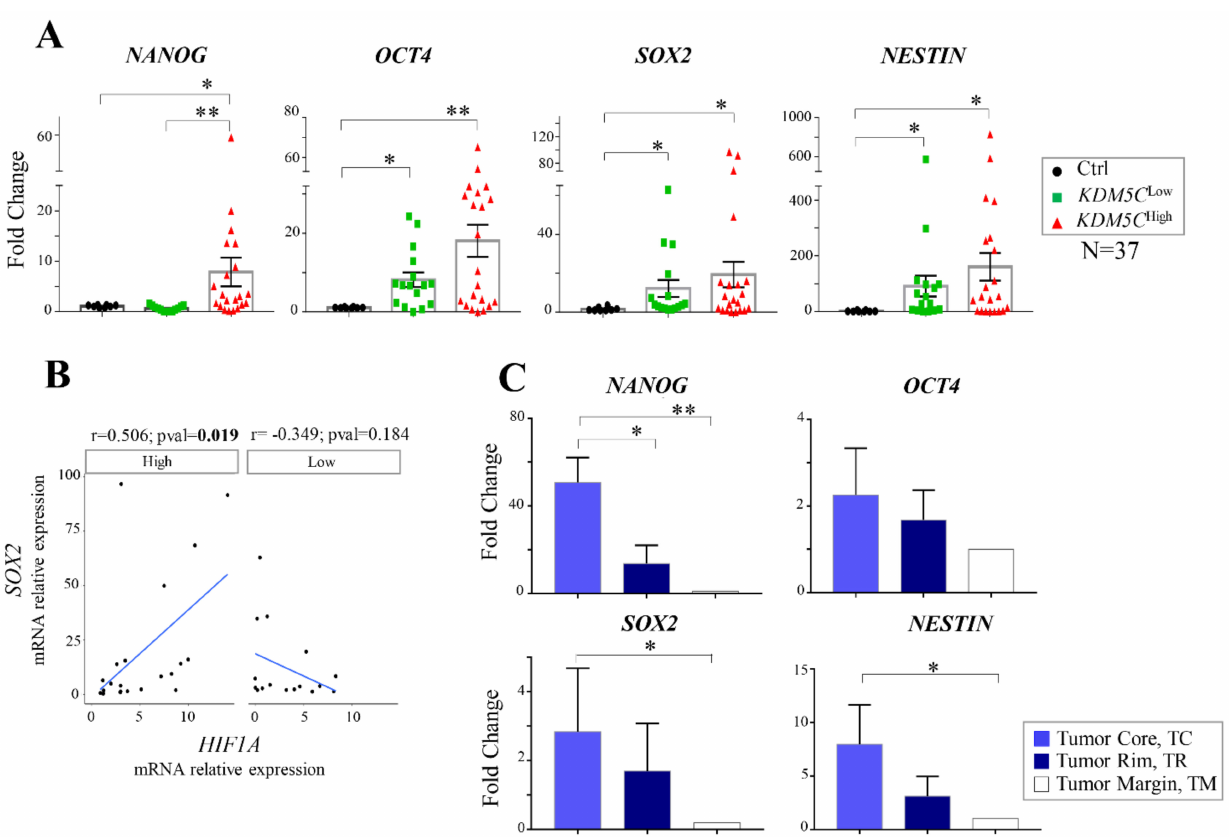
Figure 5. Expression analysis of the stem cell-associated genes in GBM tumor samples. ( A ) RT- PCR analysis of NANOG , OCT4 , SOX2 , and NESTIN in the KDM5C Low and KDM5C High cohorts. ( B ) Scatter plot reporting the correlation—by linear regression analysis—of HIF1A and SOX2 in the KDM5C Low and KDM5C High subgroups. The average expression value of healthy control samples was used as a reference. The Pearson’s correlation coefficient (r) and p -values ( p ) are indicated on the top of each plot. ( C ) RT-PCR analysis of NANOG , OCT4 , SOX2 , and NESTIN in 5-ALA FGS tissues. Each transcript analysis was performed in triplicate, and the samples were normalized with the TATA-Box Binding Protein ( TBP ) gene. The bars indicate the mean ± SEM of repeated experiments. Asterisks indicate statistical significance compared with healthy control samples: ** p < 0.005 and * p <